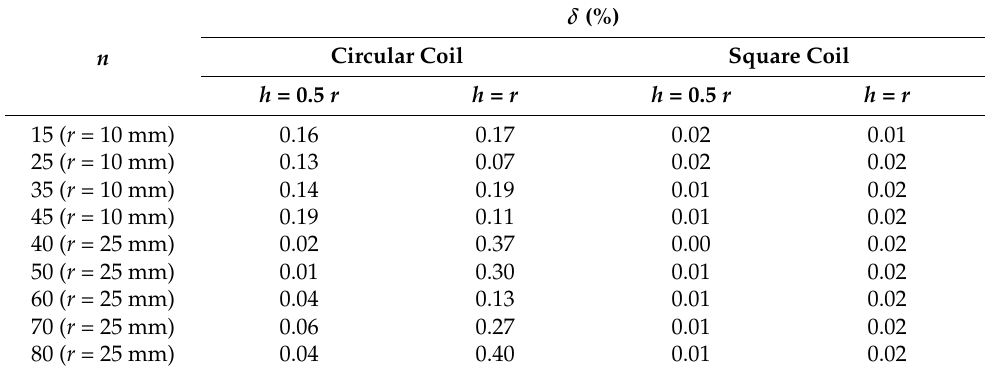
0.00.40.81.21.62.02.4